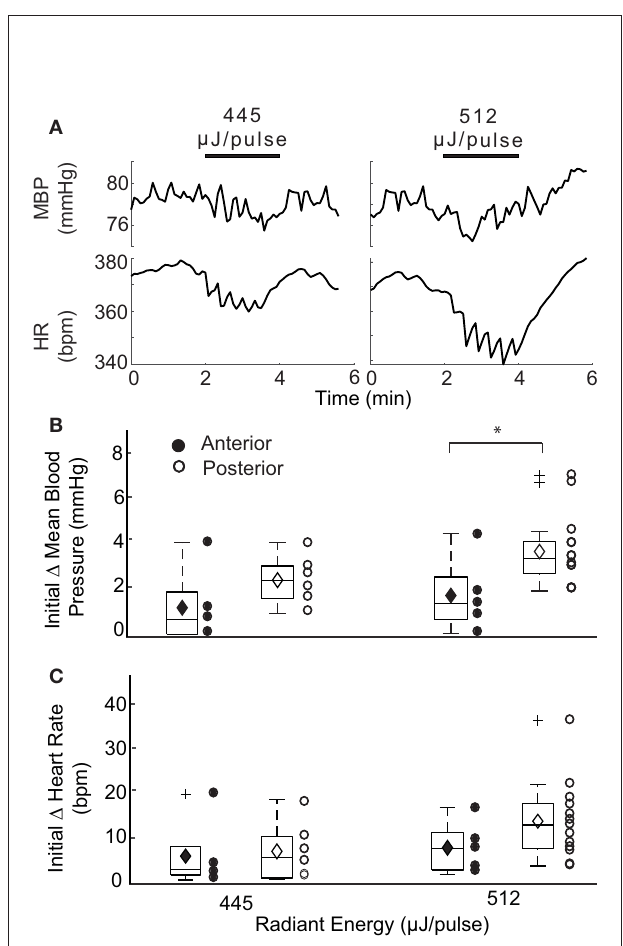
FIGURE 8 | Responses evoked with IR stimulation of the AC vs PC. (A) Shows two example responses recorded in one rat at different IR stimulation of the AC. Changes in mean BP and HR were recorded for cycles stimulated at 445 and 512 µ J/pulse. The initial decrease in BP at the higher radiant energy of 512 µ J/pulse was determined to be 0.81 mmHg. Initial decreases in HR were observed to be 3.49 and 8.17 bpm at respective radiant exposures. Box plots show comparison of the initial changes in MBP (B) and HR (C) between IR stimulation of AC (closed circle) and PC (open circle) at two different energy levels: 445 and 512 µ J/pulse. A significant difference in the responses evoked by IR stimulation of the two canals was observed in MBP and only at 512 µ J/pulse [P(T ≤ t) two tail =